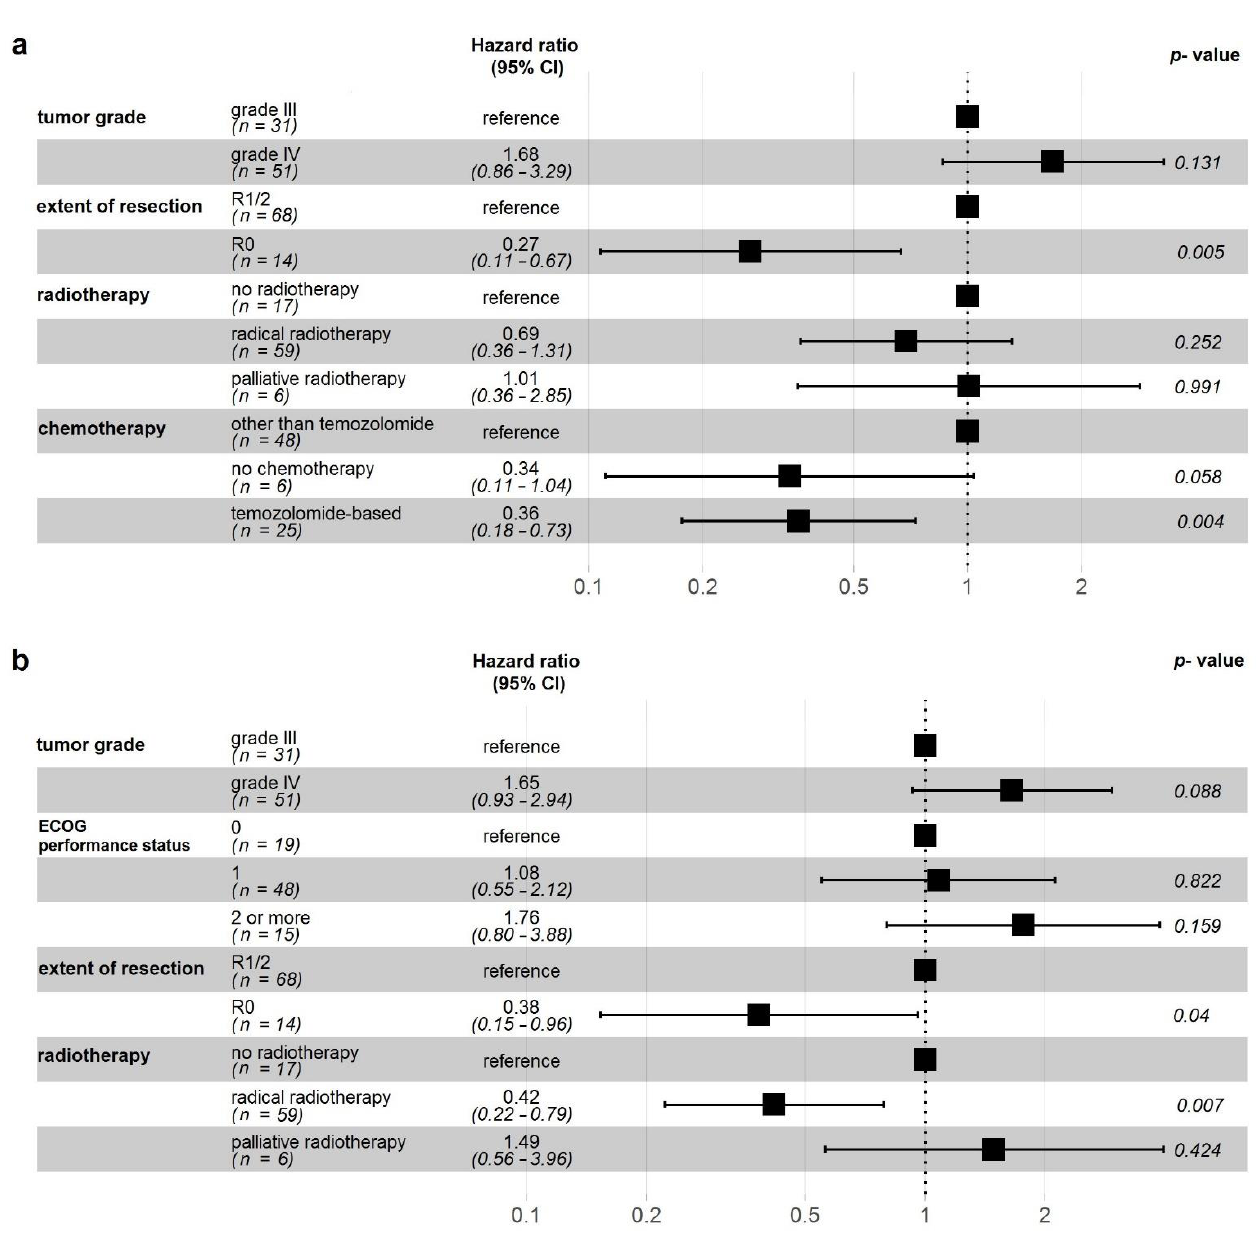
Figure 2. Hazard ratios for overall survival ( a ) and progression free survival ( b ) with 95% confidence intervals and p -values calculated from a multivariate Cox proportional-hazards model. Abbreviations: ECOG—Eastern Cooperative Oncology Group; R0—radical resection (macro- and microscopically); R1—macroscopically radical resection (but not microscopically); R2—macroscopically not-radical resection.